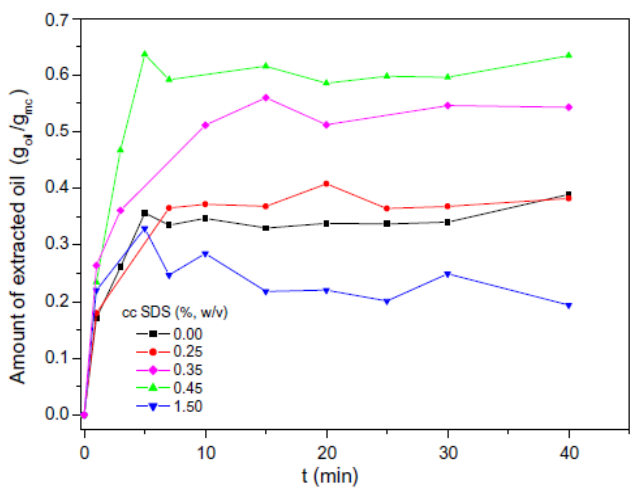
Figure 1. Amount of oil extracted from microcapsules obtained from 20% w/w sunflower oil/water emulsions in 1.00% w/w HPMC containing different SDS concentrations; redrawn from [34].